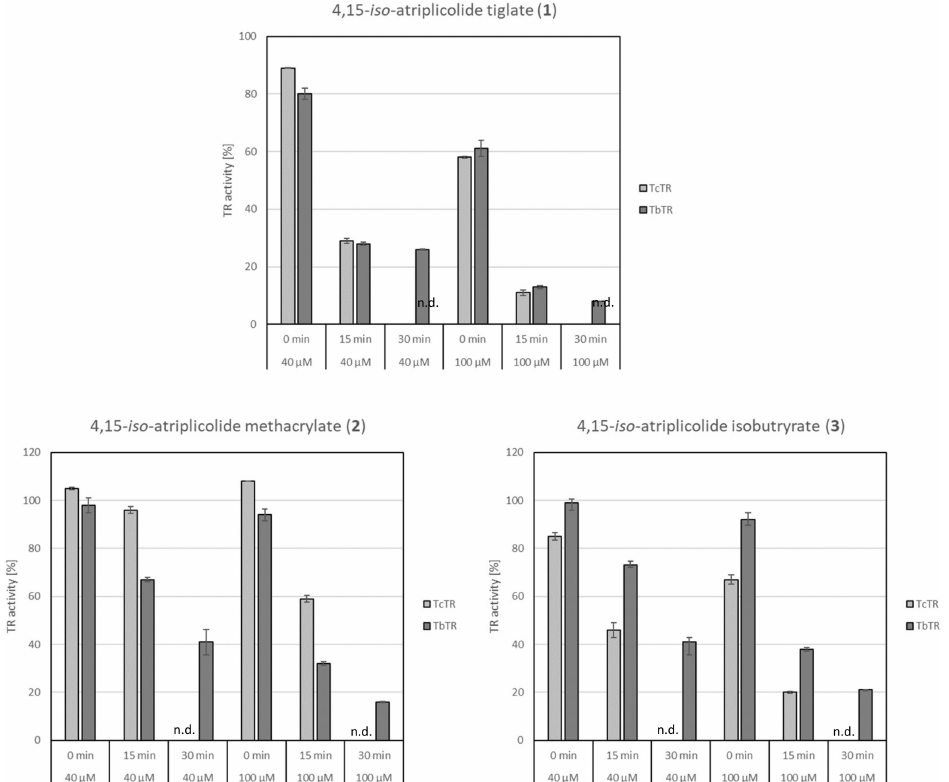
Figure 2. Inhibition of TR by STLs 1 – 3 in the presence of NADPH. Diagrams show the relative activity (% residual activity in relation to untreated controls) of Tc TR and Tb TR after the addition of each STL at the specified concentration and preincubation for the specified time. n.d.: Inhibition of Tc TR after 30 min preincubation was not